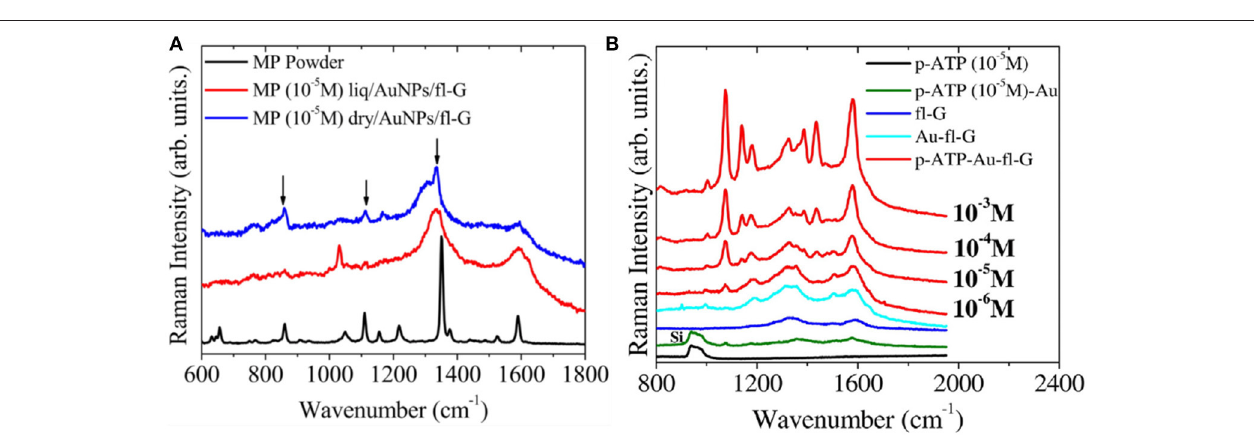
FIGURE 14 | (A) Raman spectra at 633nm of methyl parathion (MP) on Au-fl-G concentrated at 10–5M and 10–4M at liquid and dry states. (B) Raman spectra at 633nm of p-ATP(10–5M) on Si, p-ATP(10–5M) on AuNPs deposited on Si, fl-graphene, AuNPs/fl-G, and p-ATP on AuNPs/fl-G at different p-ATP concentration (10–6M, 10–5M, 10–4M, 10–3M) [Reproduced from Tite et al. (2016) with permission of Elsevier].